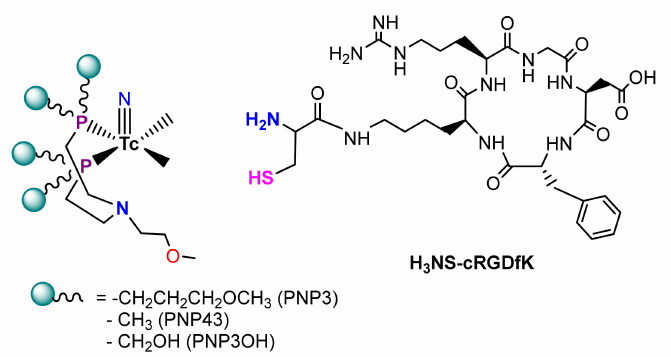
Figure 1. Left side: schematic drawing of the [ 99m Tc][Tc(N)(PNP)] synthons: PNP act as bidentate ligands, whereas the remaining two coordinative positions around the [Tc ≡ N] 2+ core are free for the coordination with a cysteine conjugated biomolecule. Right side: the cysteine-conjugated cRGDfK pentapeptide used in our